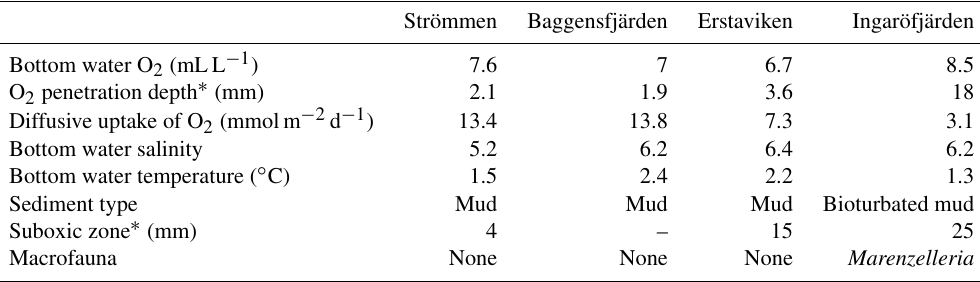
Table 2. Key site characteristics at time of sampling (March